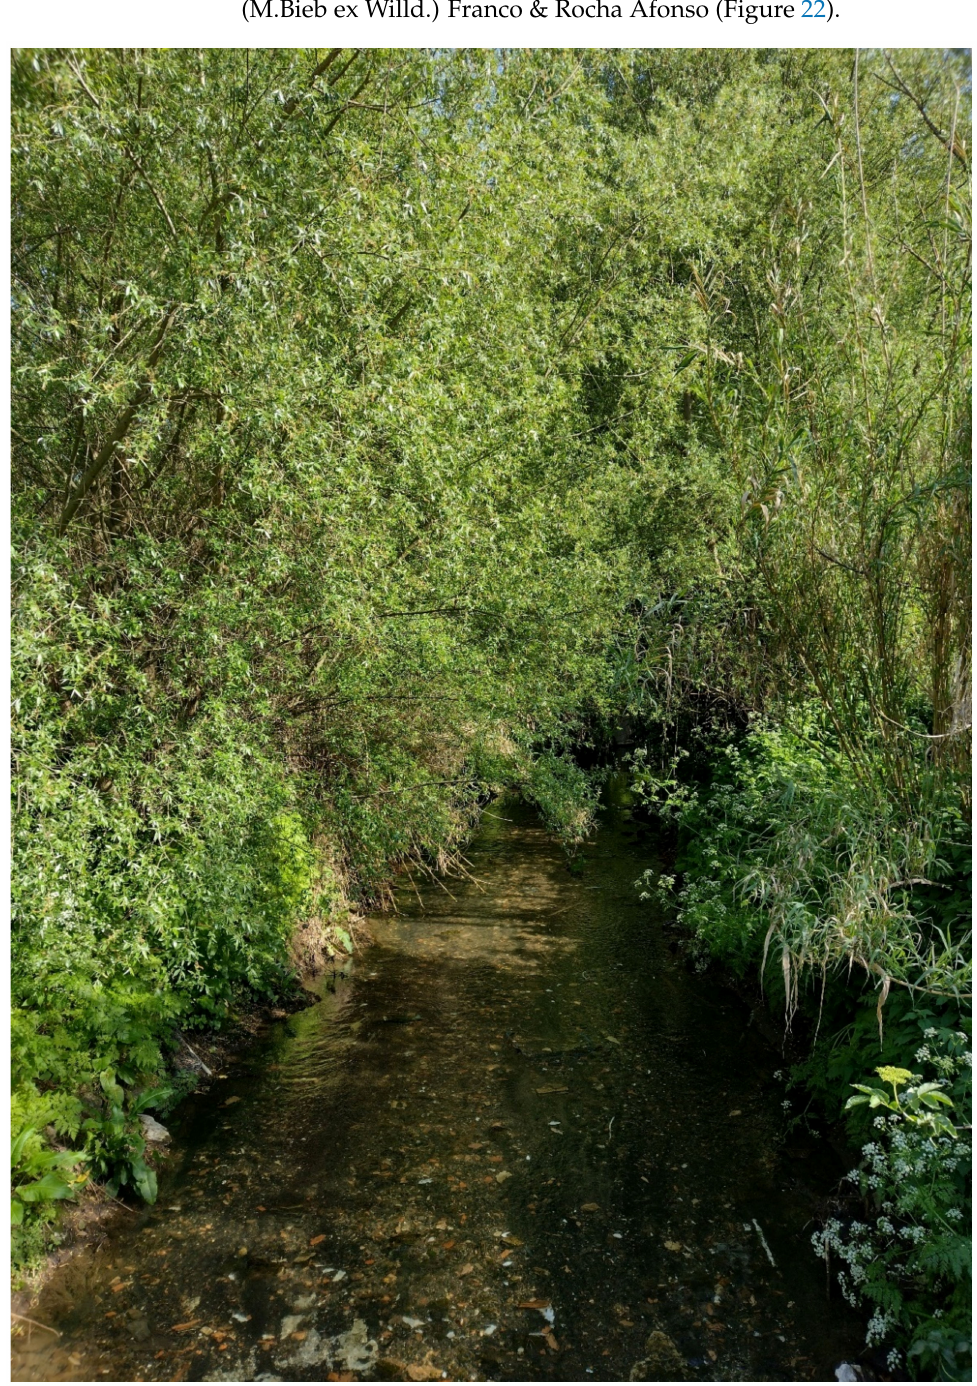
Figure 22. Riparian forest along river Almone (Caffarella